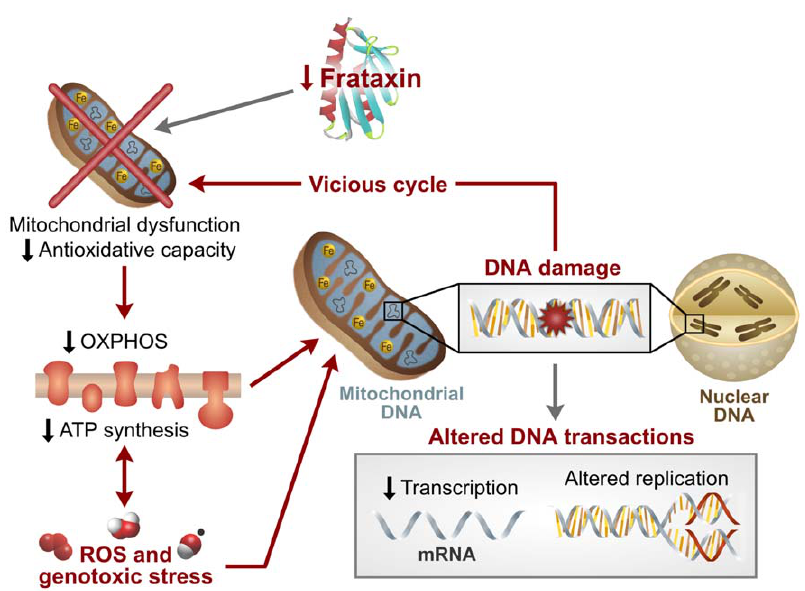
Figure 5. Model of Friedreich’s ataxia pathology based on this study. Data presented in this study are consistent with a dysregulation of mitochondrial function, decreased oxidative phosphorylation, increased ROS production, and subsequent mitochondrial and nuclear DNA damage. These factors contribute to decreased signaling and altered DNA transactions, which are likely to result in subsequent loss of protein synthesis and decreased protein degradation, as suggested in the transcription profiling. These alterations may cause tissue damage, altered immune response, and the clinical pathology associated with FRDA.